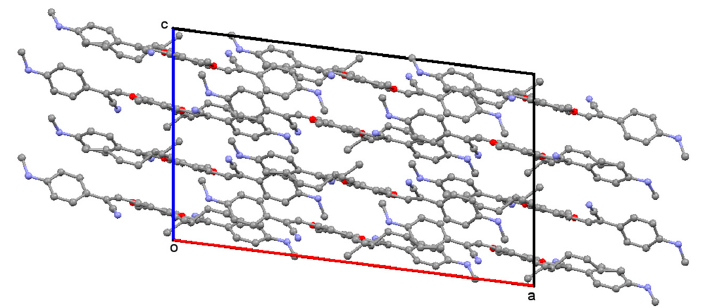
Figure 5. Crystal packing of CN-PV-NHMe viewed along b axis. Ball-and-stick style, H atoms not drawn for clarity.